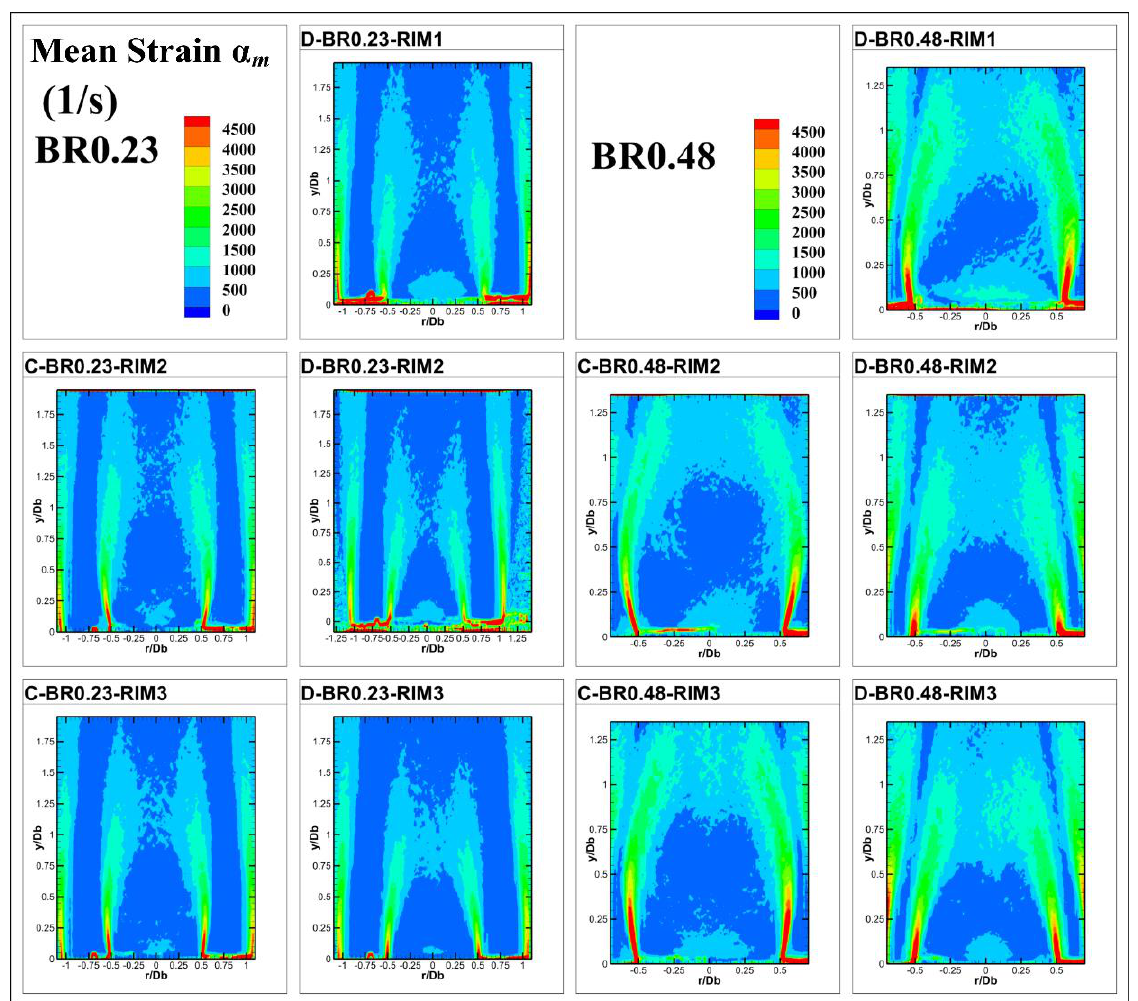
Figure 10. Mean strain rate contours for the examined bluff bodies.